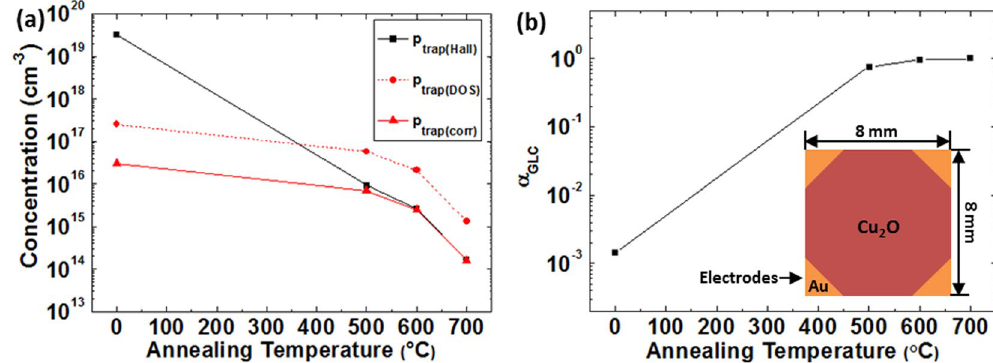
Figure 2. ( a ) p trap ( Hall ) , p trap ( DOS ) and p trap ( corr ) and ( b ) α GLC as a function of annealing temperature. Inset shows the schematic van der pauw geometry for the Hall measurement. ( a ) shows the discrepancy between p trap ( Hall ) (calculated using μ Hall including the effects of TLC and GLC) and p trap ( corr ) (i.e. p trap ( DOS ) corrected using p trap ( Hall ) (700 °C)) including only the TLC effect. In ( b ), the effect of GLC on μ Hall is quantified by α GLC (extracted using Equation (15) and the difference between p trap ( Hall ) and p trap ( corr ) ). This shows that α GLC approaches unity as annealing temperature increases: 0.0014 (as-deposited), 0.76 (500 °C), 0.96 (600 °C), 1 (700 °C). This suggests that GLC becomes insignificant after high-temperature